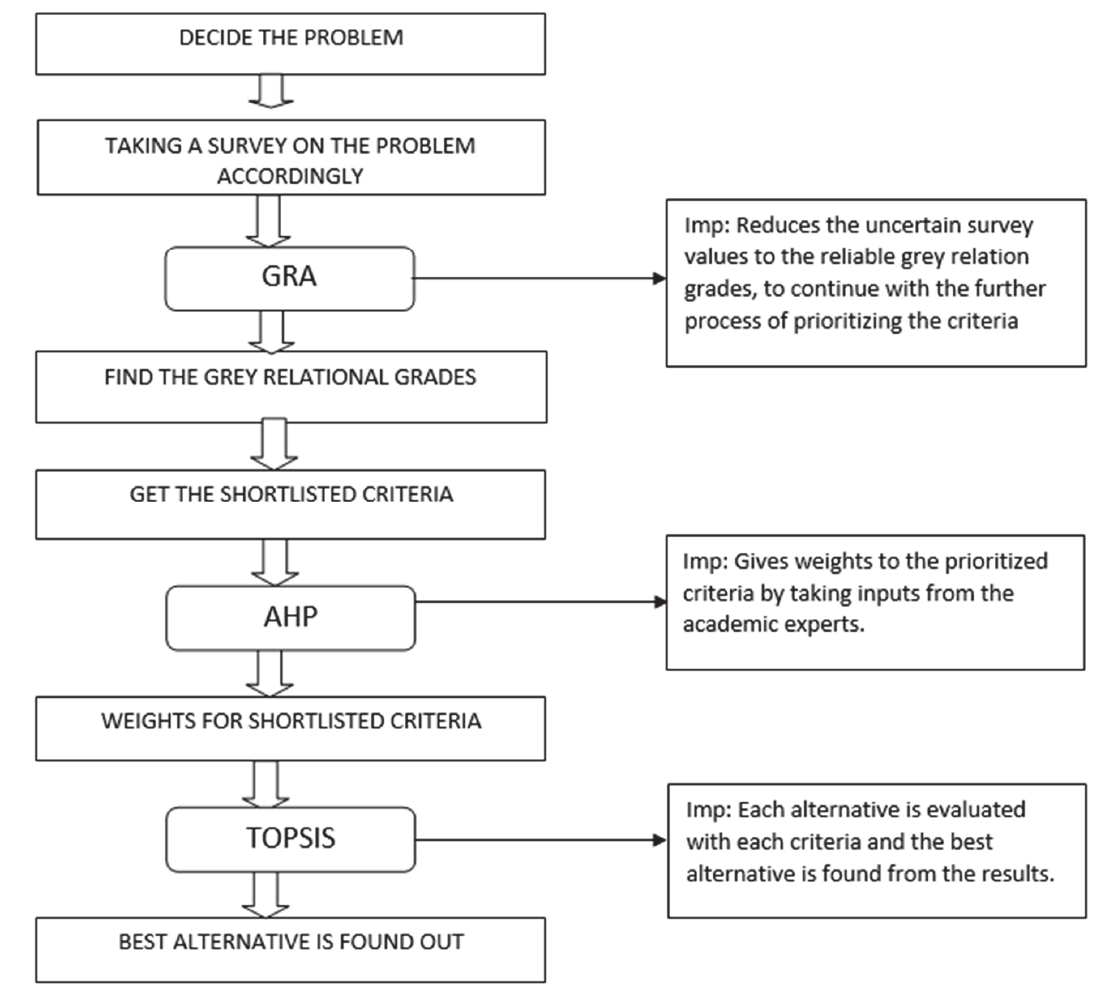
Fig. 1 . Methodology - Hybrid tool combination - GRAHP